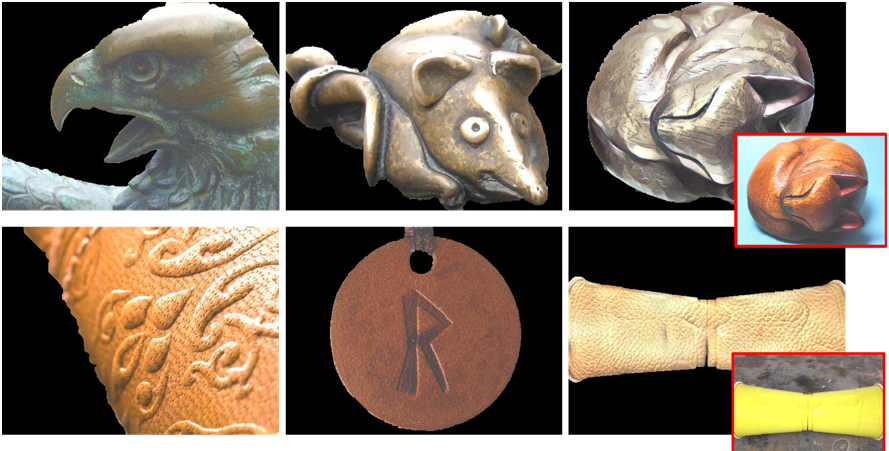
Figure 13. Examples of synthesized images with fewer votes (i.e., perceived as real). Each row shows the image triplets shown in one question (1st row: metal; 2nd row: leather). The most-voted pictures are shown from ( left ) to ( right ). The synthesized results of metal and leather got 4% and 14% of the votes, respectively (content image in